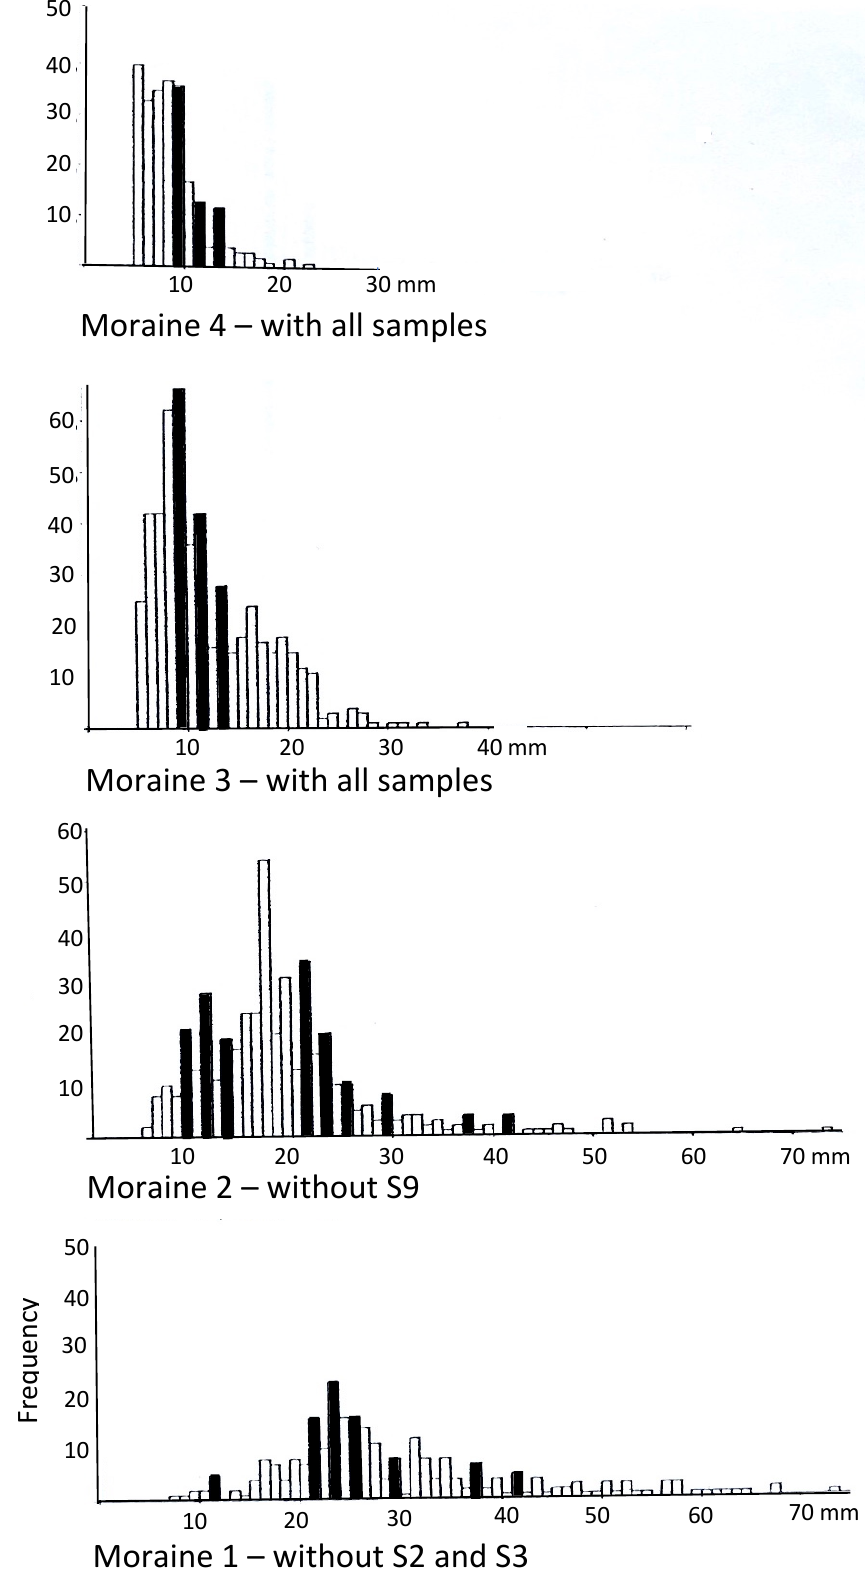
Figure 10. Size-frequency histograms for the four Cavell moraines with highlighted cross-referencing of similar class-frequencies. Similar peaks across the four moraines suggest uniformity of conditions influencing raised colonization episodes